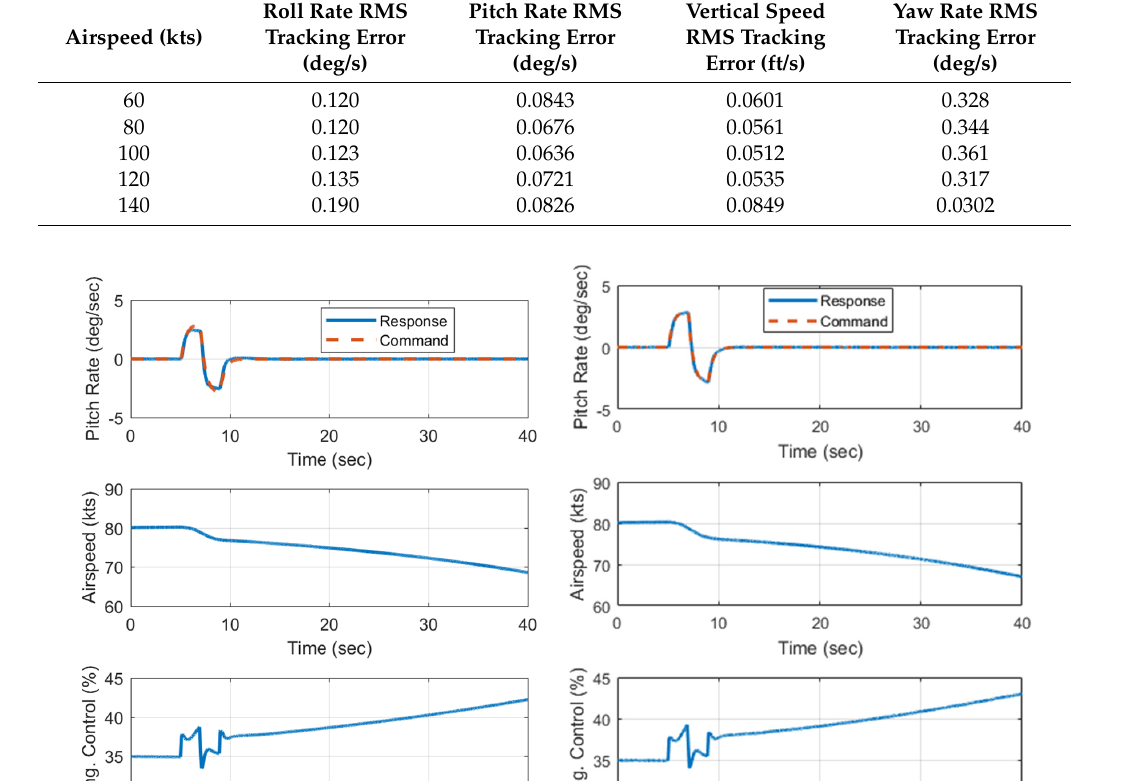
Table 7. RMS tracking errors of at various airspeeds for a 30° banked turn maneuver.